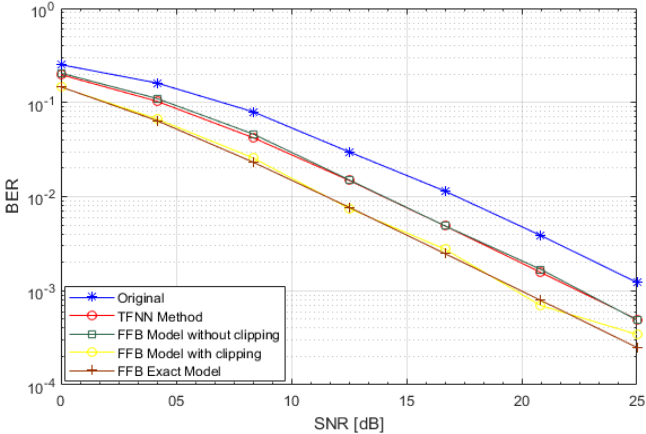
Figure 9. Bit error rate (BER) vs. SNR for the FFB algorithm.